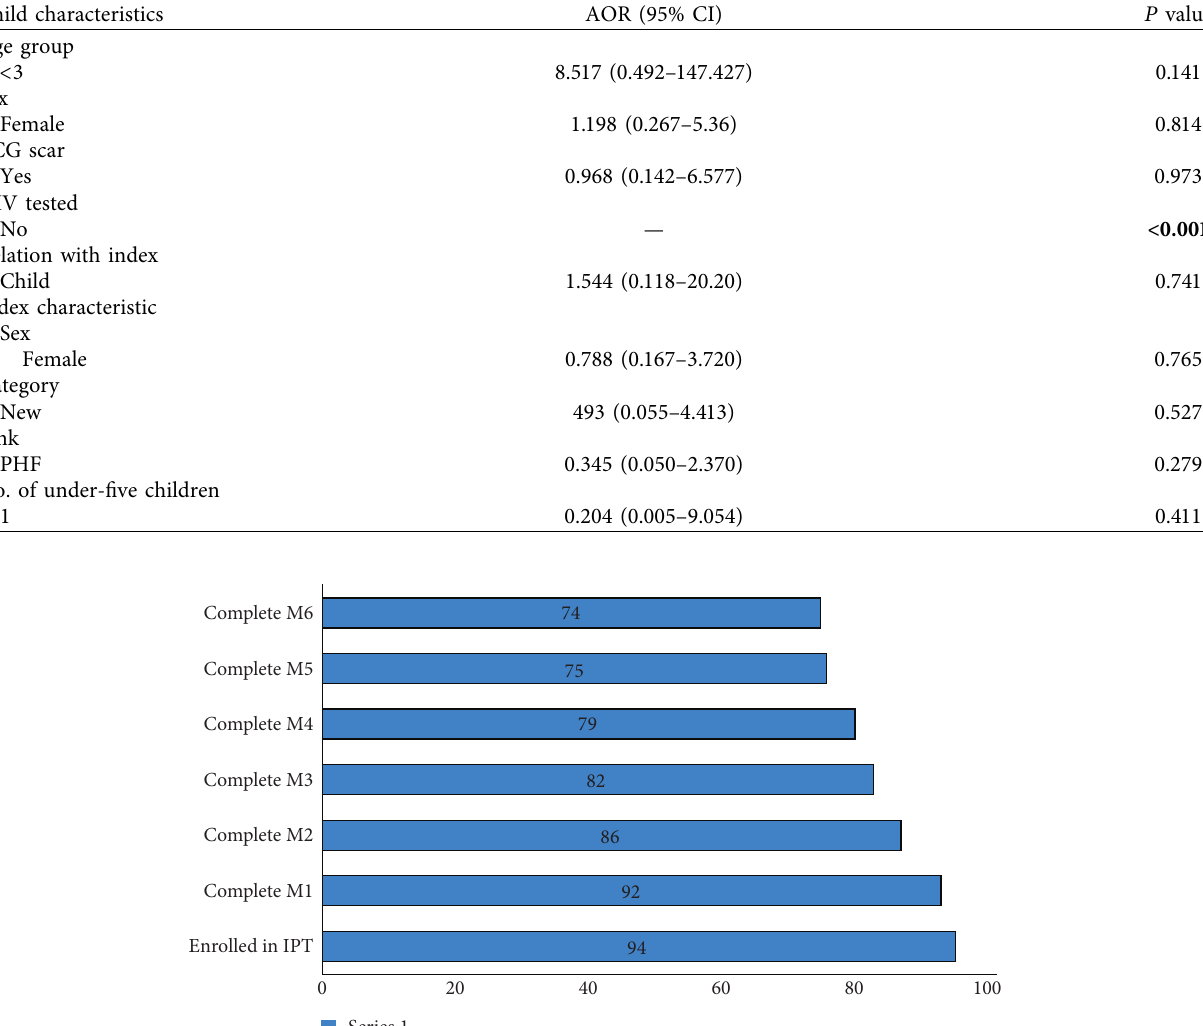
Table 3: Risk factors for noncompletion of INH prophylaxis in Addis Ababa city, 2019.